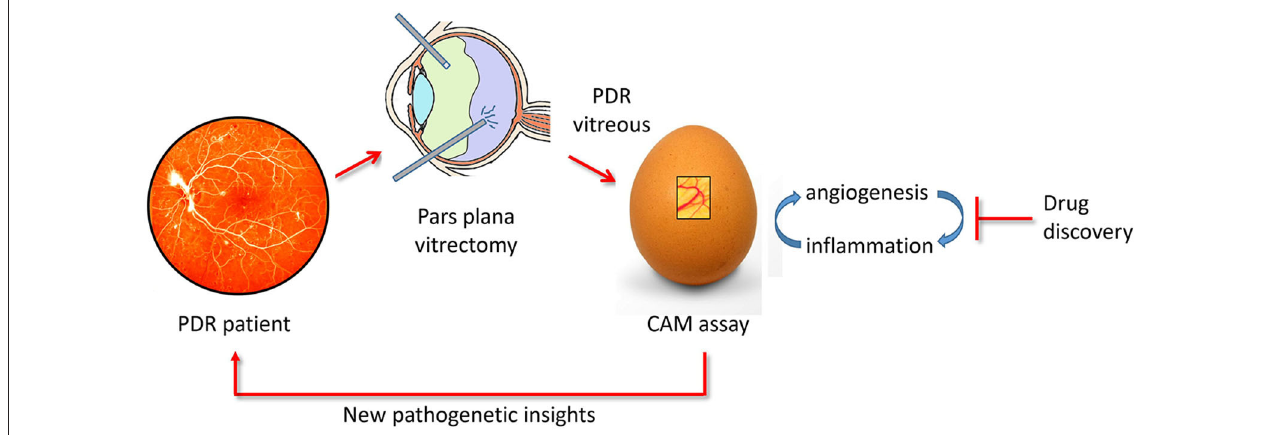
FIGURE 6 | The chick embryo CAM/PDR vitreous platform. PDR vitreous obtained by pars plana vitrectomy provides a useful tool for drug discovery when tested in the CAM assay. In addition, the study of the cross talk between the angiogenic and inflammatory responses elicited by PDR vitreous in the CAM assay may shed a new light on the pathogenesis of the